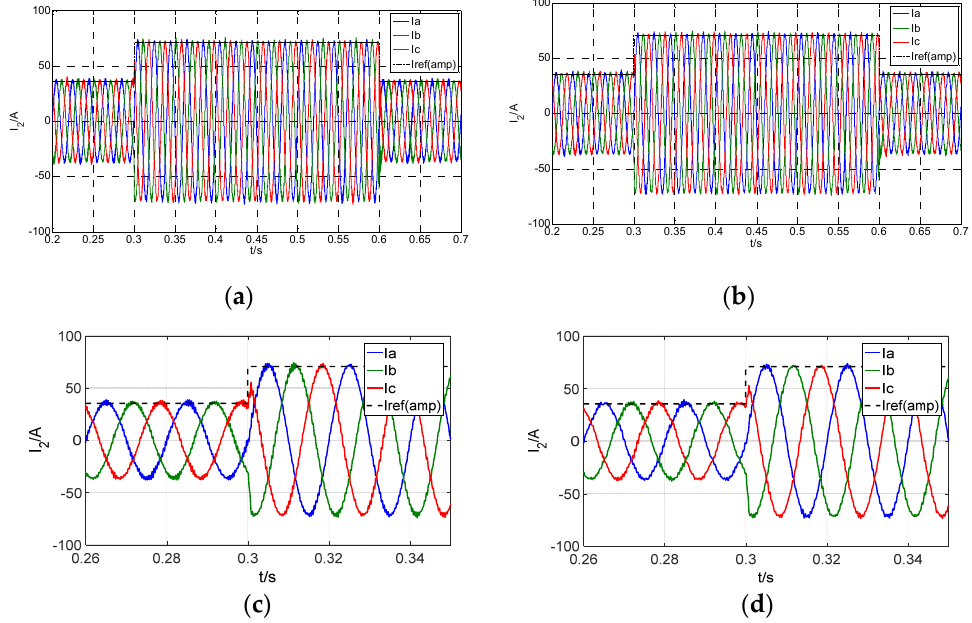
Figure 9. Dynamic current waveforms of VSI based on two control schemes: ( a ) Output current of the single closed-loop control system, ( b ) output current of the double closed-loop control system, ( c ) partial enlarged detail of ( a ), ( d ) partial enlarged detail of ( b ).